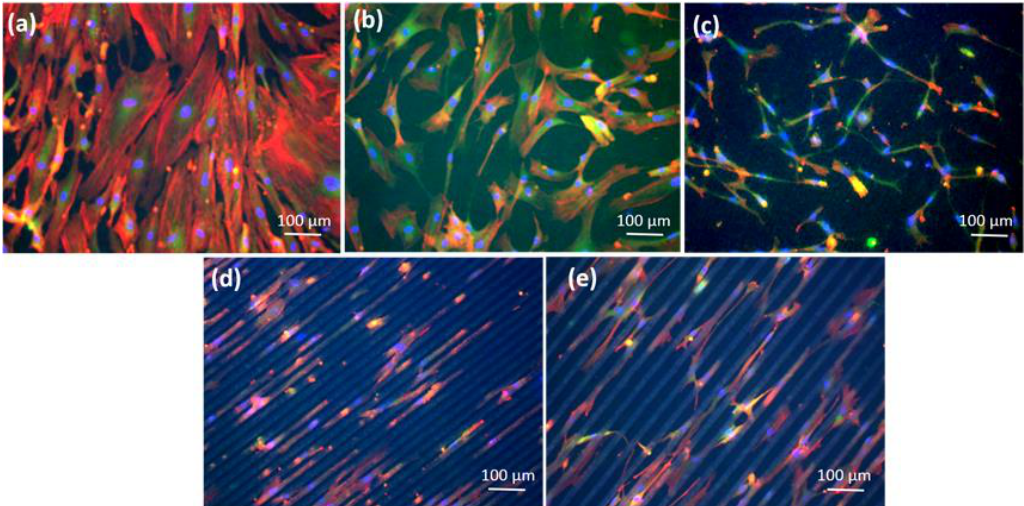
Figure 7. Representative immunofluorescence images of MSCs on glass cover slips or on four different PLLA surfaces after 14 days in culture: ( a ) MSCs on cover slips; ( b ) MSCs on FLAT PLLA; ( c ) MSCs on ROUGH PLLA; ( d ) MSCs on GROOVES 1; ( e ) MSCs on GROOVES 2. Focal adhesions marked with Vinculin are shown in green, cell cytoplasm marked with Phalloidin in red and cell nuclei marked with DAPI in blue.